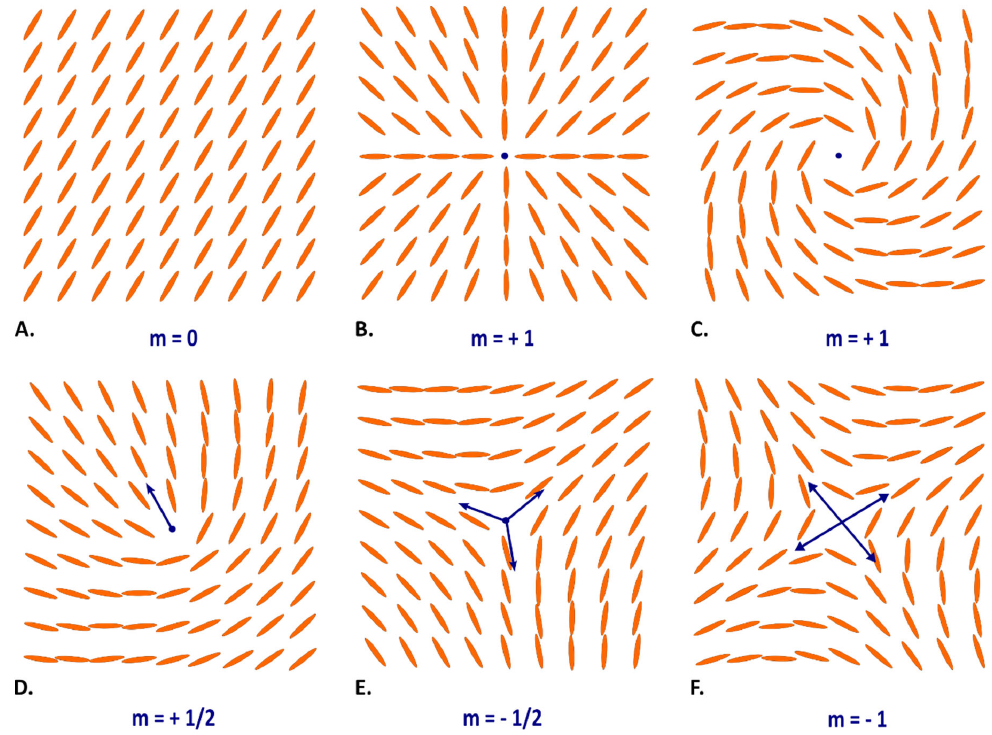
Figure 3. Examples of disclinations (topological singularities) depending on the topological charge, m, measured at the pivotal blue point, ( A ) m = 0, ( B ) m = +1, ( C ) m= +1, ( D ) m = +1/2, ( E ) m = − 1/2, ( F ) m= − 1. Blue arrows represent the major radial direction pointing out from the singularity (after Tang and Selinger [18]). The method of measurement of the topological charge m is didactically explained in Supplementary Videos S1–S4.